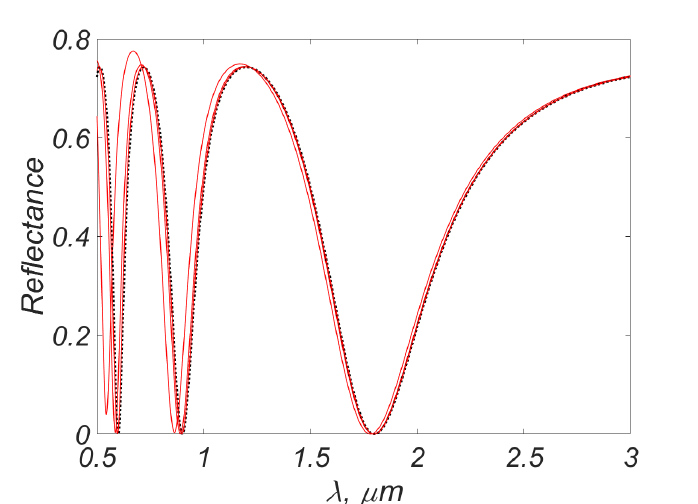
Figure 4. Fabry–Perot interferometer. The reflection spectrum for the case of s -polarization. Dotted line is calculation by the matrix method. Solid lines are calculations by the method of optical paths and the bicompact scheme on thickening grids along the ray coordinate.